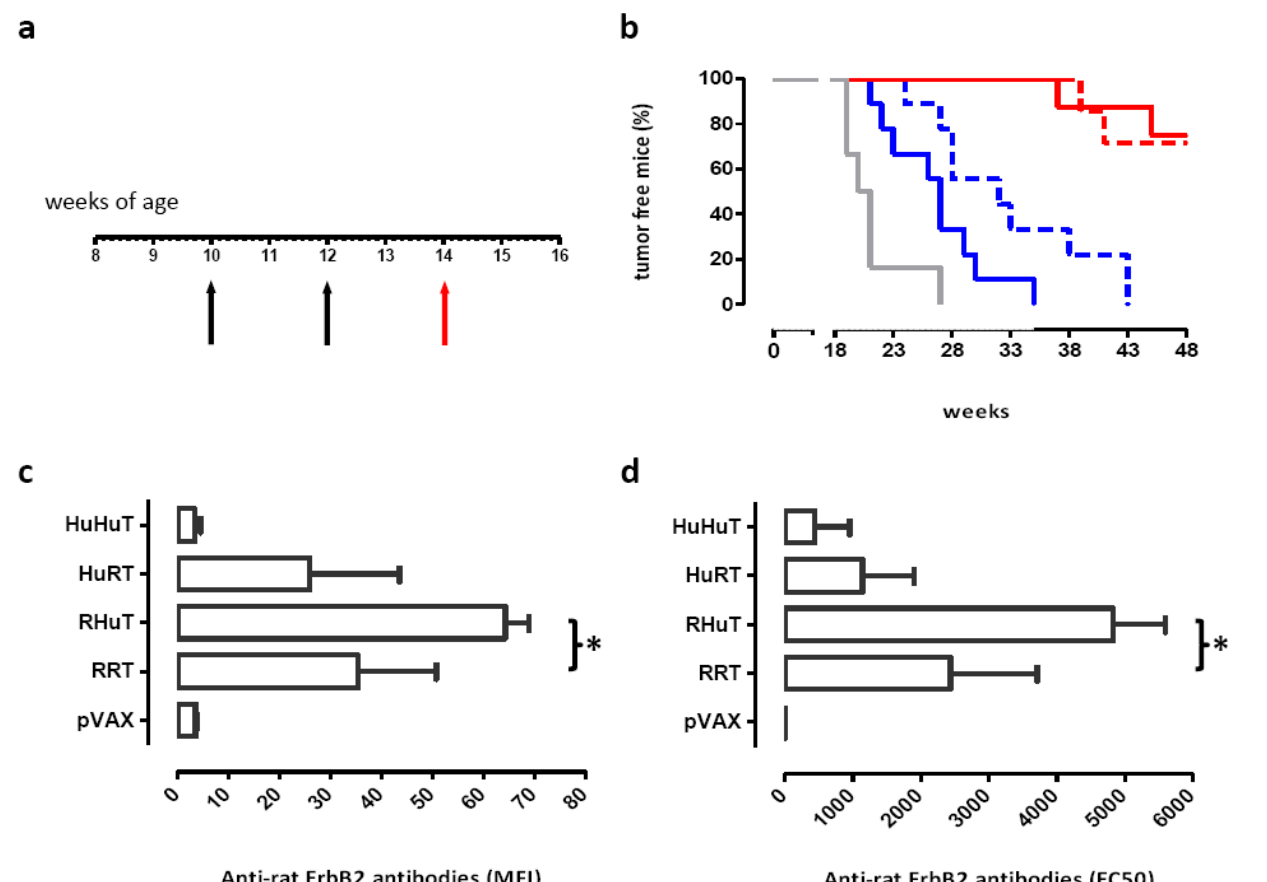
Figure 4. Protection against autochthonous ErbB2 + mammary tumors provided by vaccination with RRT, RHuT, HuRT and HuHuT plasmids in BALB-neuT mice and anti rat ErbB2 antibodies induction. (a) Experimental protocol: BALB-neuT mice were vaccinated with different plasmids when they displayed mammary atypical hyperplasia (black arrows). Two weeks after the second vaccination they were bled (red arrow), sera were collected and stored for anti rat ErbB2 antibodies evaluation; (b) Mammary tumor incidence of BALB-neuT vaccinated mice with RRT (dotted red line, n = 7 mice), RHuT (continuous red line, n = 8 mice), HuRT (dotted black line, n = 9 mice), HuHuT (continuous black line, n = 9 mice) and empty control pVAX (dotted grey line, n = 6 mice). Differences in tumor incidence were analyzed by the log-rank (Mantel-Cox) test. The anti-rat ErbB2 antibody titre was evaluated both by flow cytometry (c) and by indirect ELISA procedure (d) . Data are reported as mean MFI ± SEM (* p = 0,02, Student’s t test) and as mean EC50 ± SEM (* p = 0,04, Student’s t